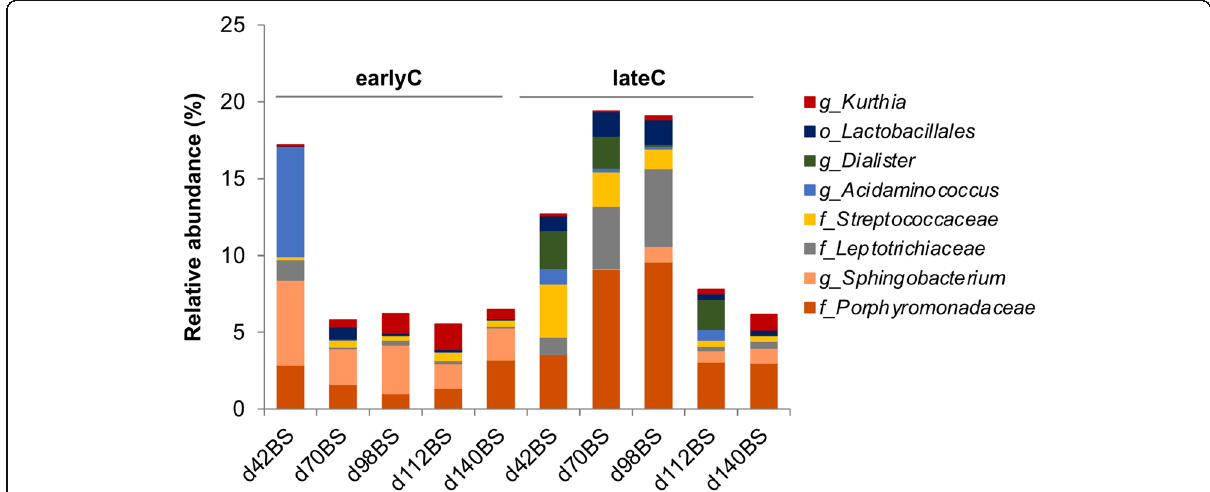
Fig. 7 Average relative abundances of OS bacterial genus-level taxa in BS samples of different weaning groups of calves. Each bar represents an average value for animals at each age group-weaning period combinations: day 42BS (4 & 4 animals), day 70BS (11 & 13 animals), day 98BS (27 & 21 animals), day 112BS (21 & 20 animals) and day 140BS (24 & 16 animals) for earlyC and lateC groups respectively. Only taxa that showed significant differences ( p ≤ 0.05) between the two weaning groups in a given sampling day are indicated